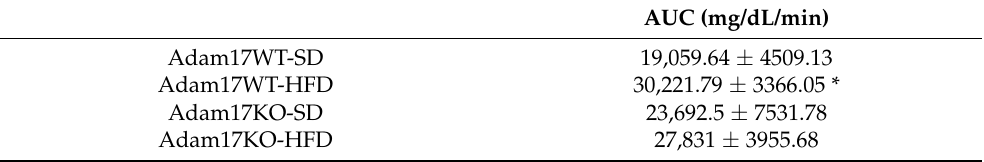
Table 2. Area under the curve was calculated for each experimental group using the trapezoid method ( n = 8). Data are expressed as mean ± SD. Abbreviations: SD, standard diet; HFD, high fat diet; Adam17WT, wild-type; Adam17KO, knockout. * p < 0.05 Adam17WT-HFD vs.